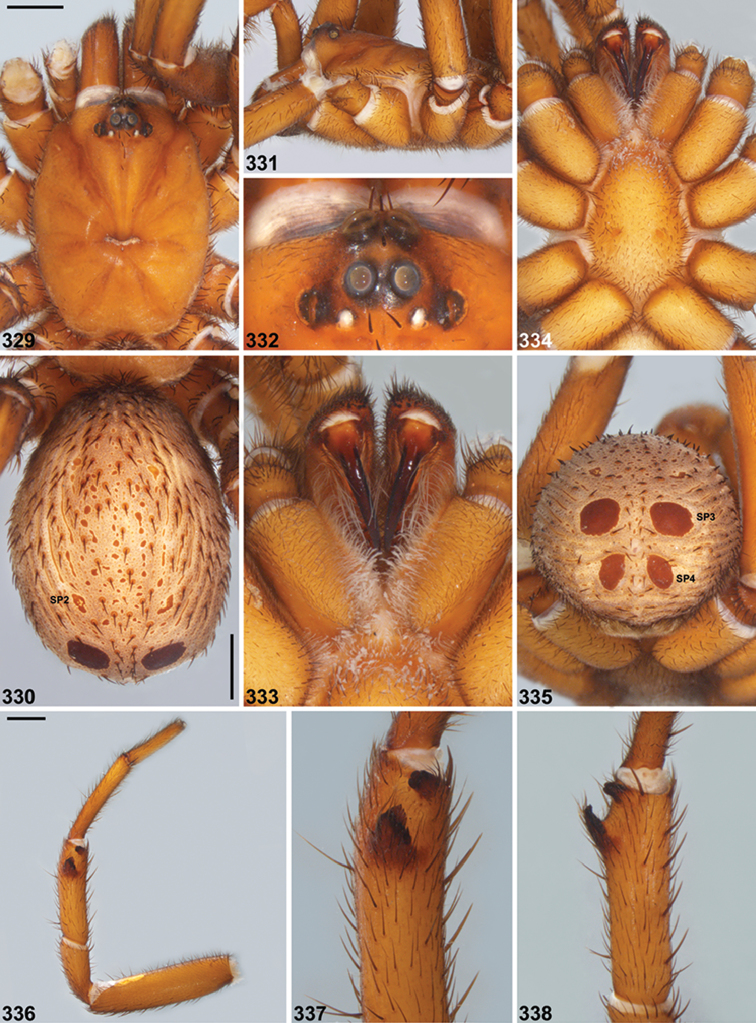

Idiosoma
schoknechtorum sp. n., male holotype (WAM T139512) from Beverley (Western Australia; AVW), somatic morphology. 329–330 Carapace and abdomen, dorsal view 331 Carapace, lateral view 332 Eyes, dorsal view 333 Mouthparts, ventral view 334 Sternum, ventral view 335 Abdomen, posterior view 336 Leg I, prolateral view 337 Leg I tibia, clasping spurs, prolateral view 338 Leg I tibia, proventral view. Scale bars 2.0. SP2–4 = sigilla pairs 2–4.